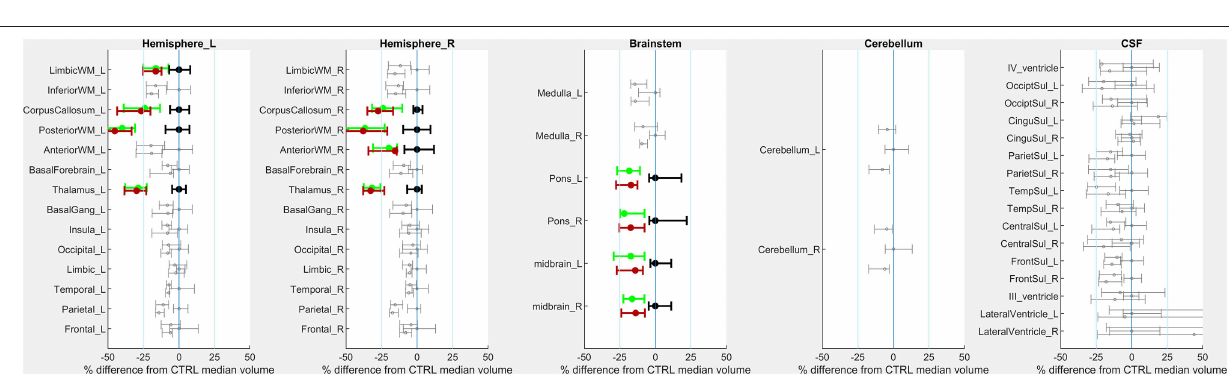
significantly lower mean FA within bilateral posterior thalamic radiations, sagittal striata, and middle cerebellar peduncles ( Figure 2